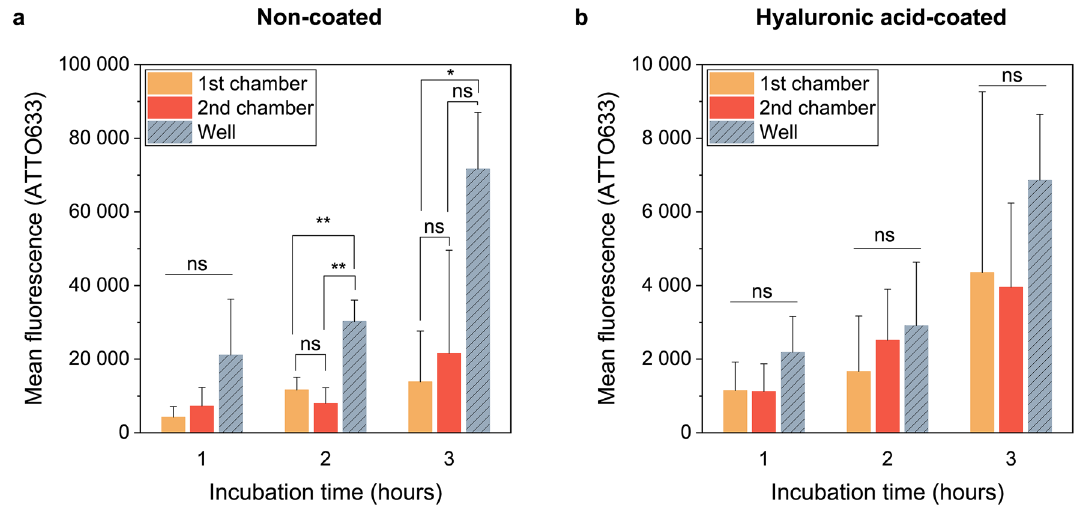
Figure 5. Liposomal uptake by A549 cells. Cells were incubated with ATTO633-labelled liposomes under static or dynamic conditions for 1, 2, or 3 h. The fluorescence intensity was measured with flow cytometry. ( a ) The mean fluorescence of cells incubated with non-coated liposomes. The cells were cultured either in QuasiVivo chambers or 24-well plates (mean ± s.d., n = 3). ( b ) The mean fluorescence of cells incubated with hyaluronic acid-coated liposomes. The cells were cultured either on QuasiVivo chambers or 24-well plates (mean ± s.d., n = 3). See Supplementary Fig. S3 for the fluorescence intensity histograms of each experiment. *p < 0.05, **p < 0.01, ns not